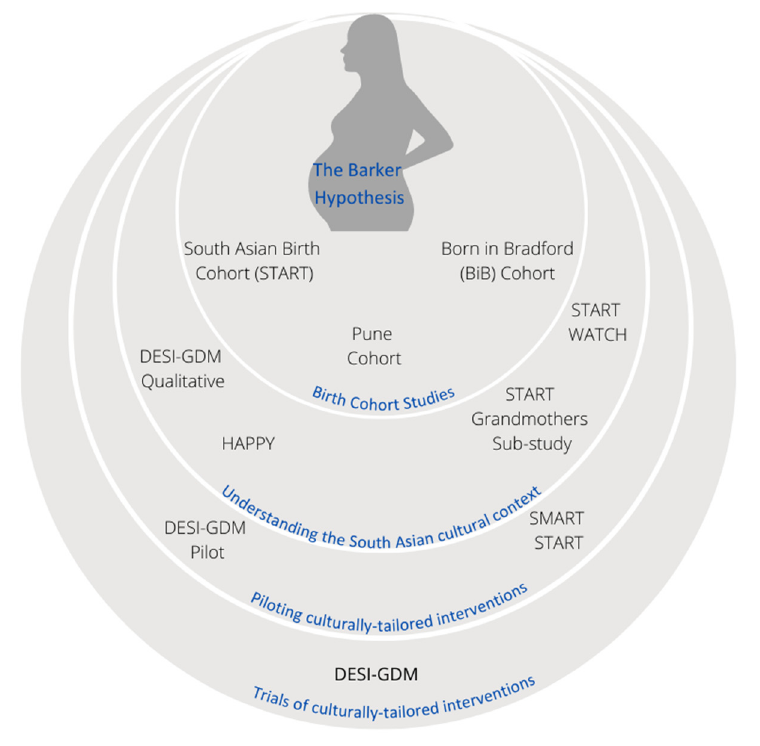
Figure 1. The evolution of SA perinatal health in South Asian women research, inspired by the Barker hypothesis. The Barker hypothesis gave rise to birth cohort studies, which encouraged the development of culturally tailored interventions and evaluations.